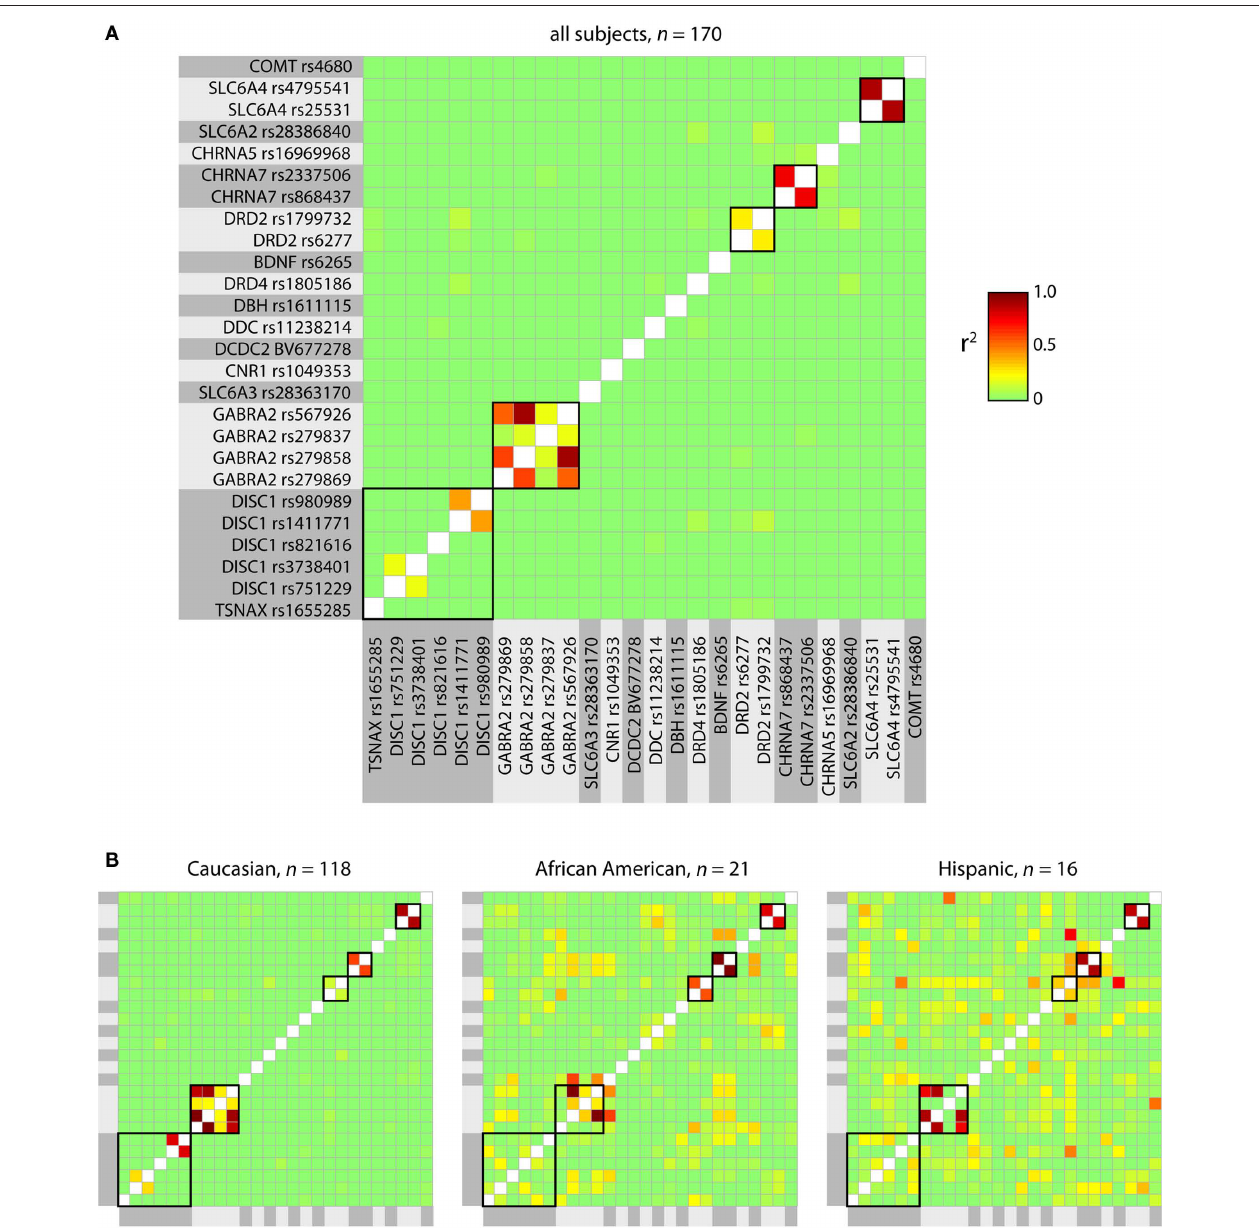
subjects in (A) , and in (B) is computed separately for the 3 largest subsets of subjects identifying as Caucasian (left, n = 118), African American (middle, n = 21), and Hispanic (right, n = 16). Correlation structure is similar between groups, though differences in magnitude